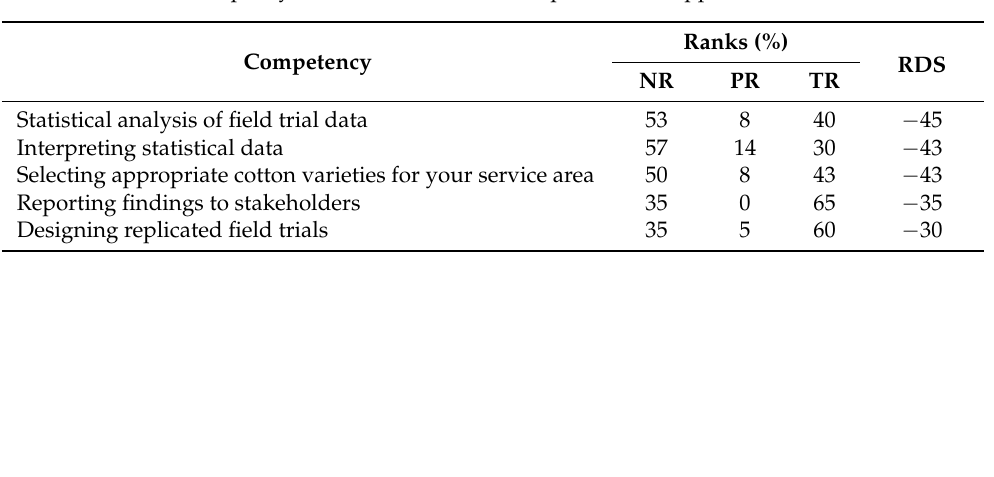
Ranks (%) RDS NR PR